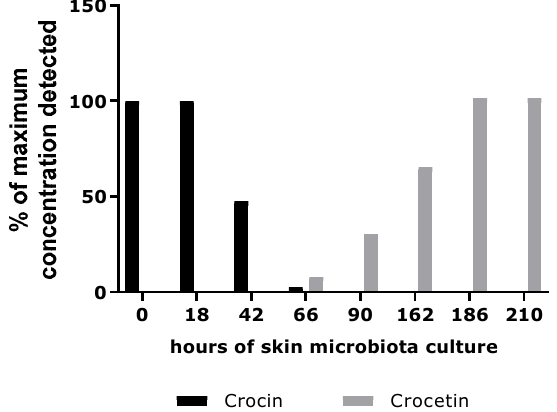
Figure 7. Dosage of crocin and crocetin in a skin microbiota culture with crocin.